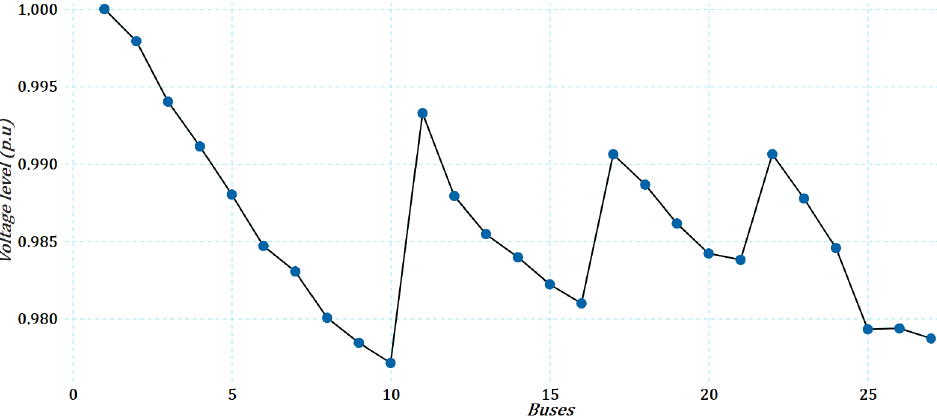
Figure 9. Voltage profiles in the buses for the IEEE system of 27 buses (balanced).